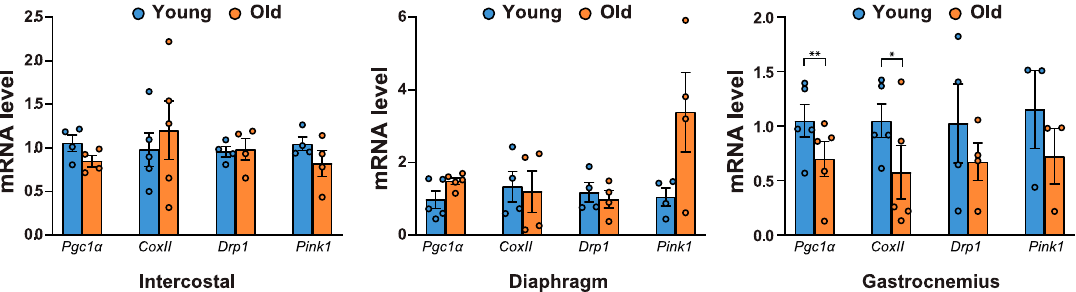
Figure 5. mRNA levels of mitochondrial quality-related genes in aged muscles. Each muscle was lysed and subjected to RT-qPCR analysis ( n > 4). Rat 18S rRNA was used to normalize gene expression. The data are shown as the mean ± standard deviation. Statistical analysis was performed using unpaired Student’s t-test. * p < 0.05; ** p < 0.01; 6-month-old versus 20-month-old rat muscles. Abbreviations: 6-month-old rat (Young); 20-month-old rat (Old).